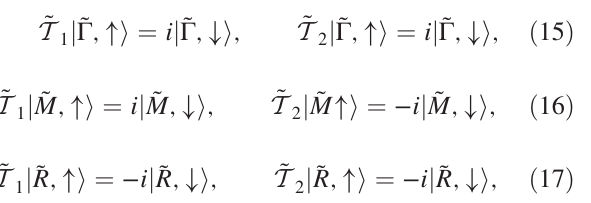
FIG. 2. (a) The (crystal) Brillouin zone of the original pyrochlore lattice. (b) Under the Q ¼ 2 π ð 001 Þ Melko-Hertog-Gingras (MHG) spin ice state, the unit cell is enlarged. The plot is the magnetic Brillouin zone corresponding to the enlarged unit cell. (c) The spin configuration of the MHG spin ice state. It is a 2-in – 2-out spin ice state with Q ¼ 2 π ð 001 Þ ordering wave vector. The magnetic unit cell ˜ ’ s is defined in Appendix A. (d) The folded band of the Ir electrons without f - d exchange develops a quadratic touching at ˜ Γ . b with i High symmetry momentum lines are defined in (b) as blue